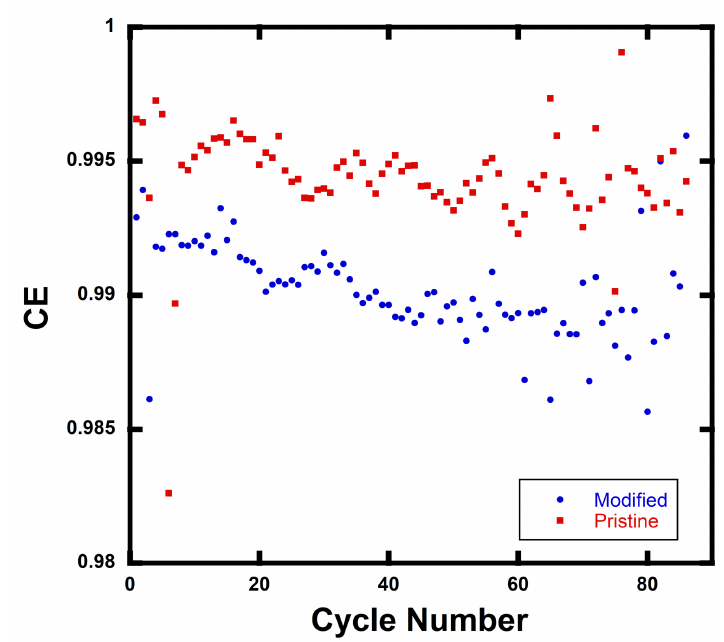
Figure 5. Coulombic efficiency (CE) vs. cycle number for 88 cycles. Pristine represents the control NMC811 battery where no rGO was added. Modified represents the rGO/NMC811 battery with 5wt% rGO. Testing was performed over a voltage window of 2.5–4.5 V at